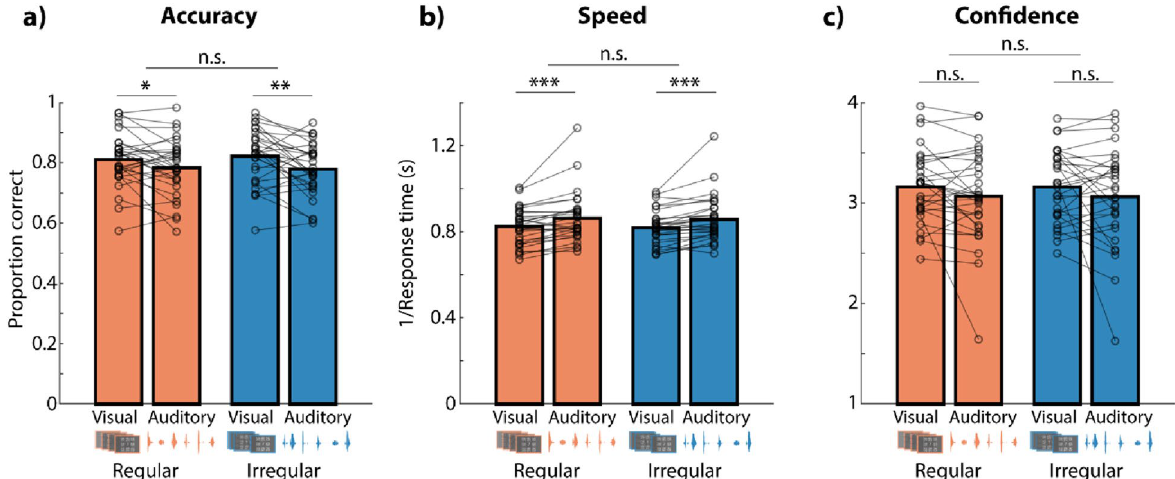
Figure 4. Bars show average accuracy ( a ), speed ( b ), and confidence rating ( c ) for distraction in different modalities (visual vs. auditory) and for regular vs. irregular distractors in Experiment 4. Lines show data from individual participants. n.s. not significant, *p < 0.05, **p < 0.01, ***p <